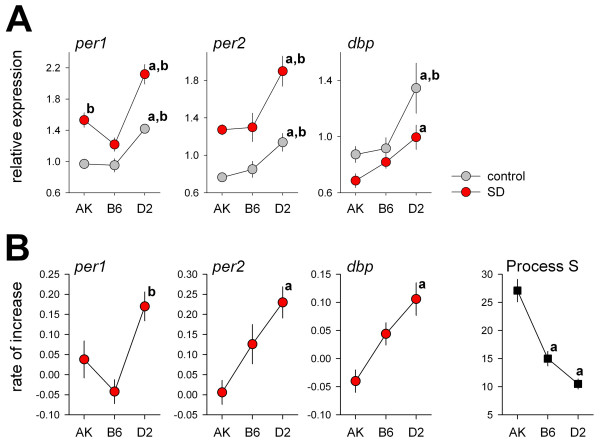
A) Average mRNA levels under both control (mean ZT1-6; ± 1SEM; n = 12/strain; grey) and SD (mean ZT1-6; red symbols; n = 12/strain) conditions were generally higher in D2 mice compared to AK and B6 mice ['a' (> AK), 'b' (> B6) P < 0.05; post-hoc Tukey]. No genotype differences were observed for ldha expression (not shown). B) Mean (± 1SEM; n = 12/genotype) slope of the regression lines quantifying the relationship between SD duration (1-, 3-, and 6 h) and clock-gene expression (fraction/h; see Fig.1) in the forebrain of AK, B6, and D2 mice. Changes in expression were affected by genotype (2-way ANOVA: 'genotype'-'ZT' interaction: per1: P = 0.0002; per2: P = 0.032; dbp: P = 0.0002). Slopes were steepest for D2 mice and the strain distribution pattern for this phenotype seemed to negatively correlate with the increase of EEG delta power (%/h) during wakefulness (i.e., 'Process S' in lower right panel; modified from [25]; with permission).